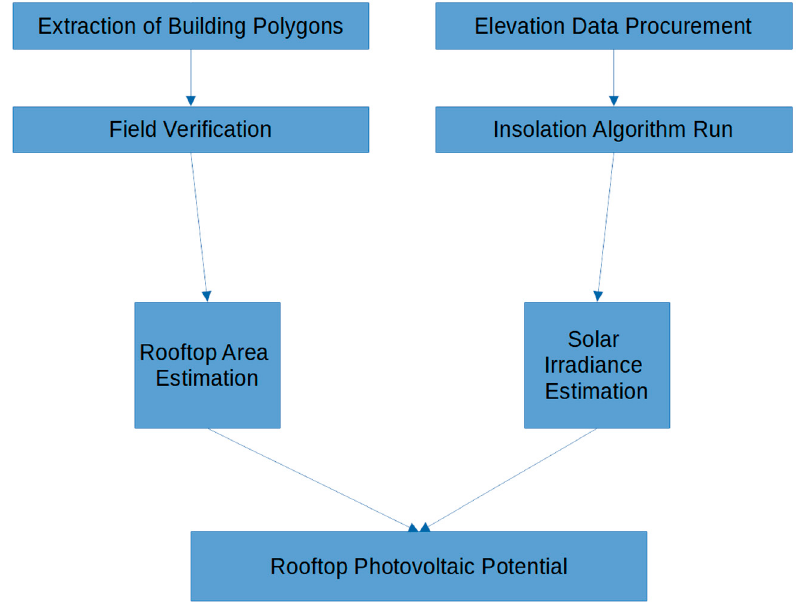
Figure 2. Flowchart of the method.